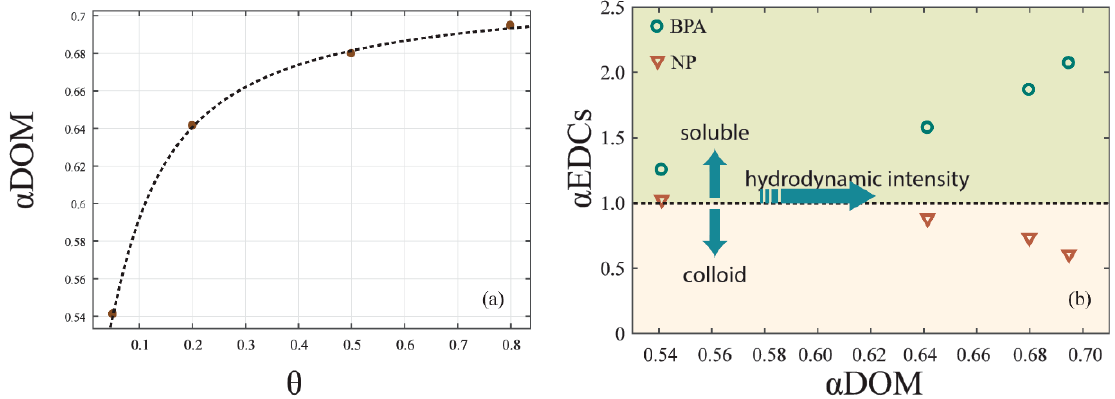
Figure 6. The e ff ect of DOM on the EDCs distribution. ( a ) The correlation of α DOM and hydrodynamic Figure 6. The effect of DOM on the EDCs distribution. ( a ) The correlation of α DOM and intensity. ( b ) The correlation of α EDCs and α DOM under hydrodynamic hydrodynamic intensity. ( b ) The correlation of α EDCs and α DOM under hydrodynamic forces.